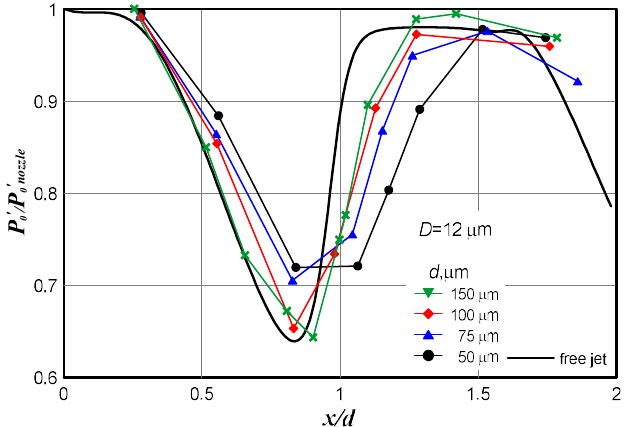
Figure 5. Calculated impingement of jets escaping from nozzles of different diameters onto the Pitot tube 12 µm in diameter.